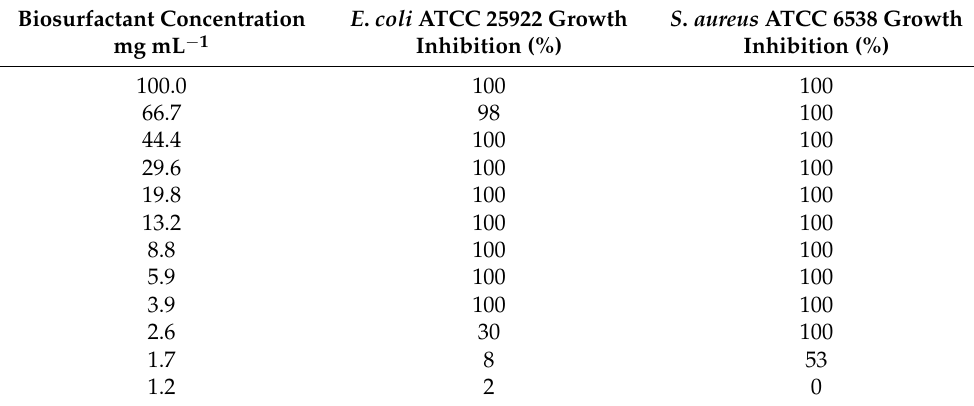
Table 1. MIC spectrum of the purified biosurfactant produced by R . opacus R7 against E . coli ATCC 29522 and S . aureus ATCC 6538.